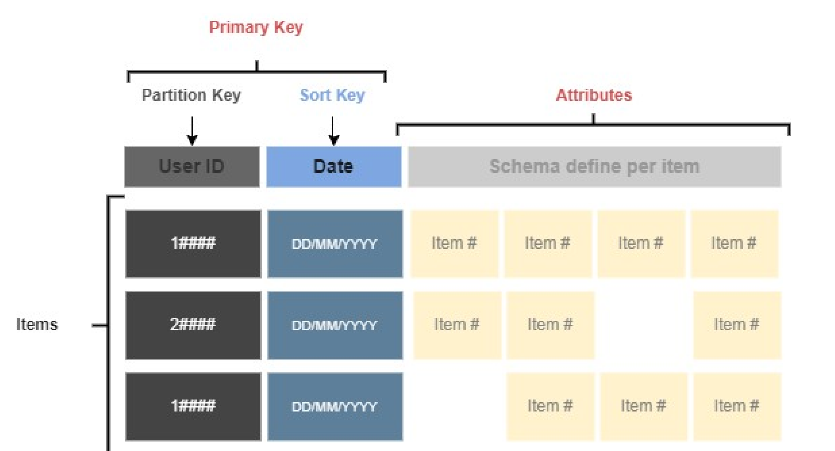
Figure 4. Lambda Functions for reception of data.